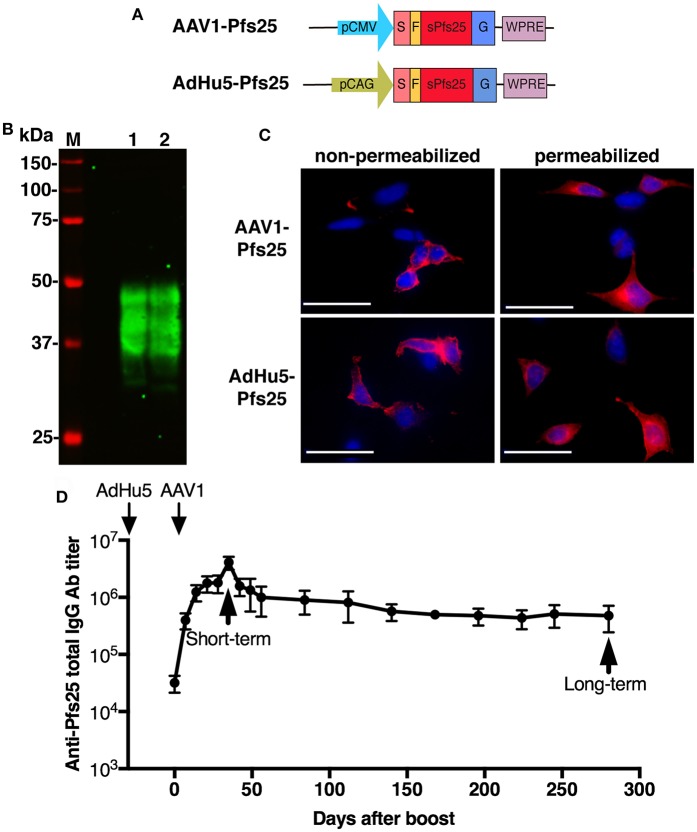
Functional activity of AdHu5-Pfs25 and AAV1-Pfs25. (A) Constructs of AdHu5-Pfs25 and AAV1-Pfs25. Expression of the pfs25 gene cassette in AAV1 and AdHu5 was driven by a CMV promoter and CAG promoter, respectively. (B) Expression of Pfs25 in HEK293T cells transduced with AdHu5-Pfs25 (lane 1, MOI = 10) or AAV1-Pfs25 (lane 2, MOI = 106), as assessed by western blotting using anti-Pfs25 mAb 4B7. (C) Localization of Pfs25 expression in HEK293T cells transduced with AAV1-Pfs25 (MOI = 105) and AdHu5-Pfs25 (MOI = 10), as determined by IFA using Alexa-Fluor-594-conjugated 4B7 (red). (D) Monitoring of the anti-Pfs25 IgG titer. BALB/c mice (n = 5–10) were immunized with the indicated regimens at a 6-week-interval. Serum samples were collected from each mouse at 1 day before boost and weekly after boost. Anti-Pfs25 IgG titers were determined by ELISA and monitored for 280 days after booster injection. Right and left down arrows indicate prime and boost injections, respectively.